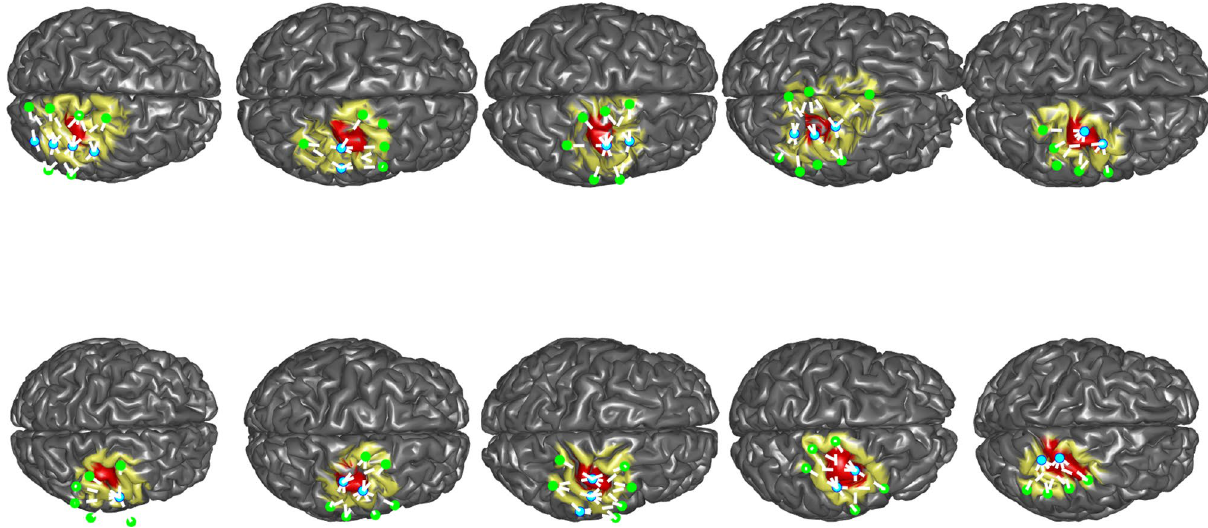
Figure 1. Representation of the 10 anatomical models considered for realistic simulations: sources of the optimal montage are represented in blue, detectors are represented in green. The white line represent the different pairs of the montage. The montage FOV (vertices where the sensitivity matrix > 10% of max) is represented in yellow on the cortical surface. The right hand knob area manually segmented to define a target for the optimal montage is represented in